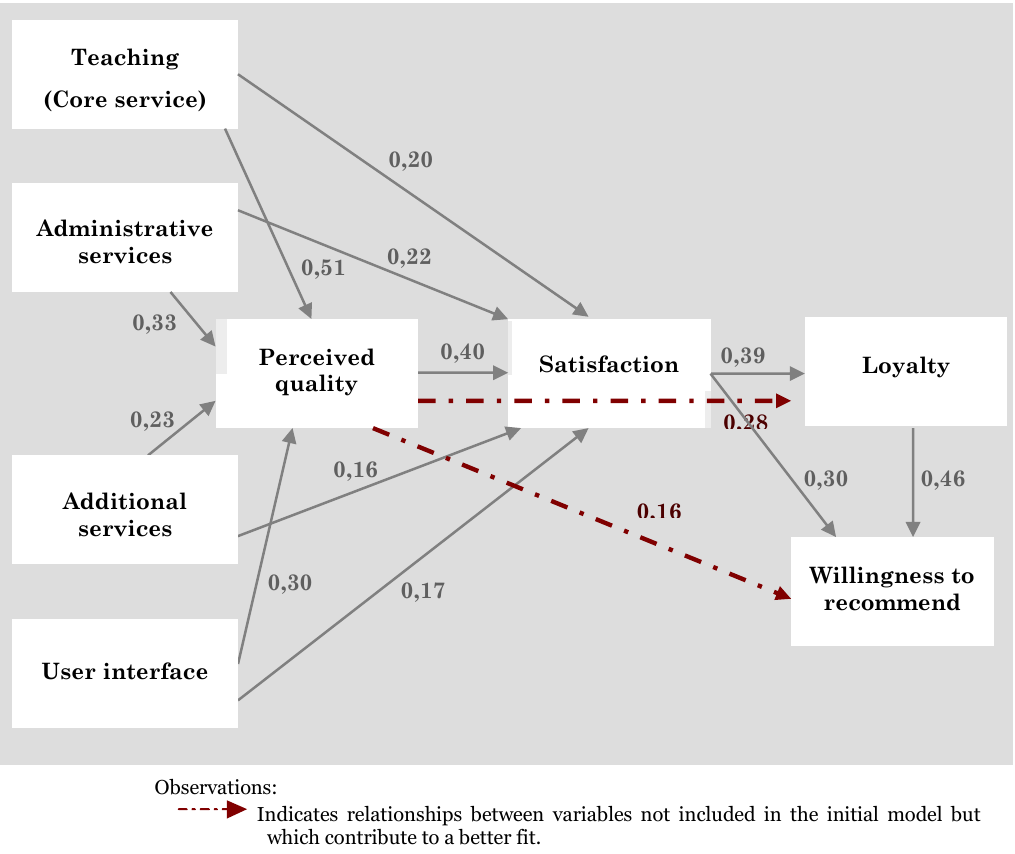
Figure 2. Structural model of relationships between the key